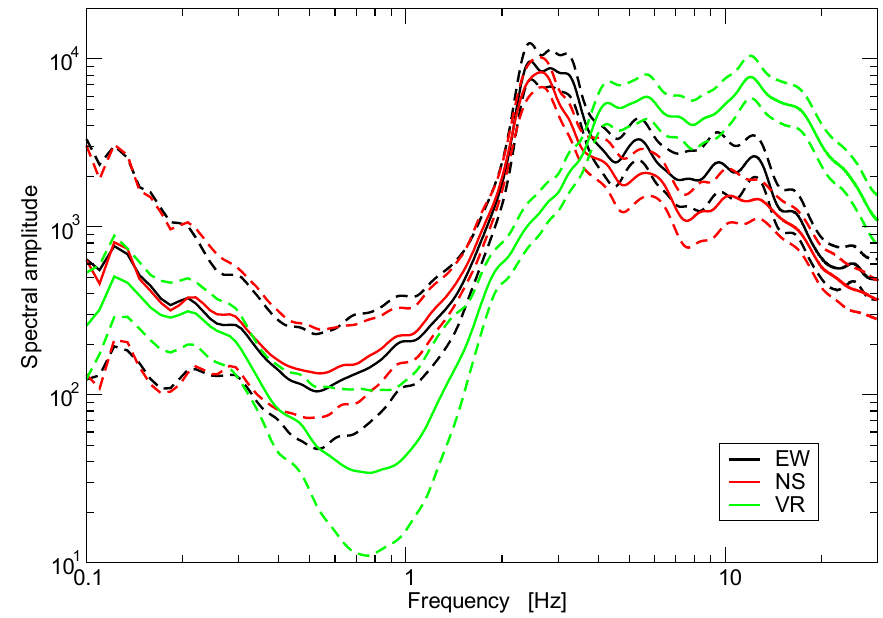
Figure 7. Average spectral amplitudes for the three components of ground motion (horizontal motion EW and NS; VR stands for vertical) computed for the broad band records of seismic noise at station EST. Solid lines indicate average values. Dashed lines show average values plus or minus one standard deviation. A total of 236 amplitude spectra, each one corresponding to a 60-s duration window of ambient noise, were averaged for each component.